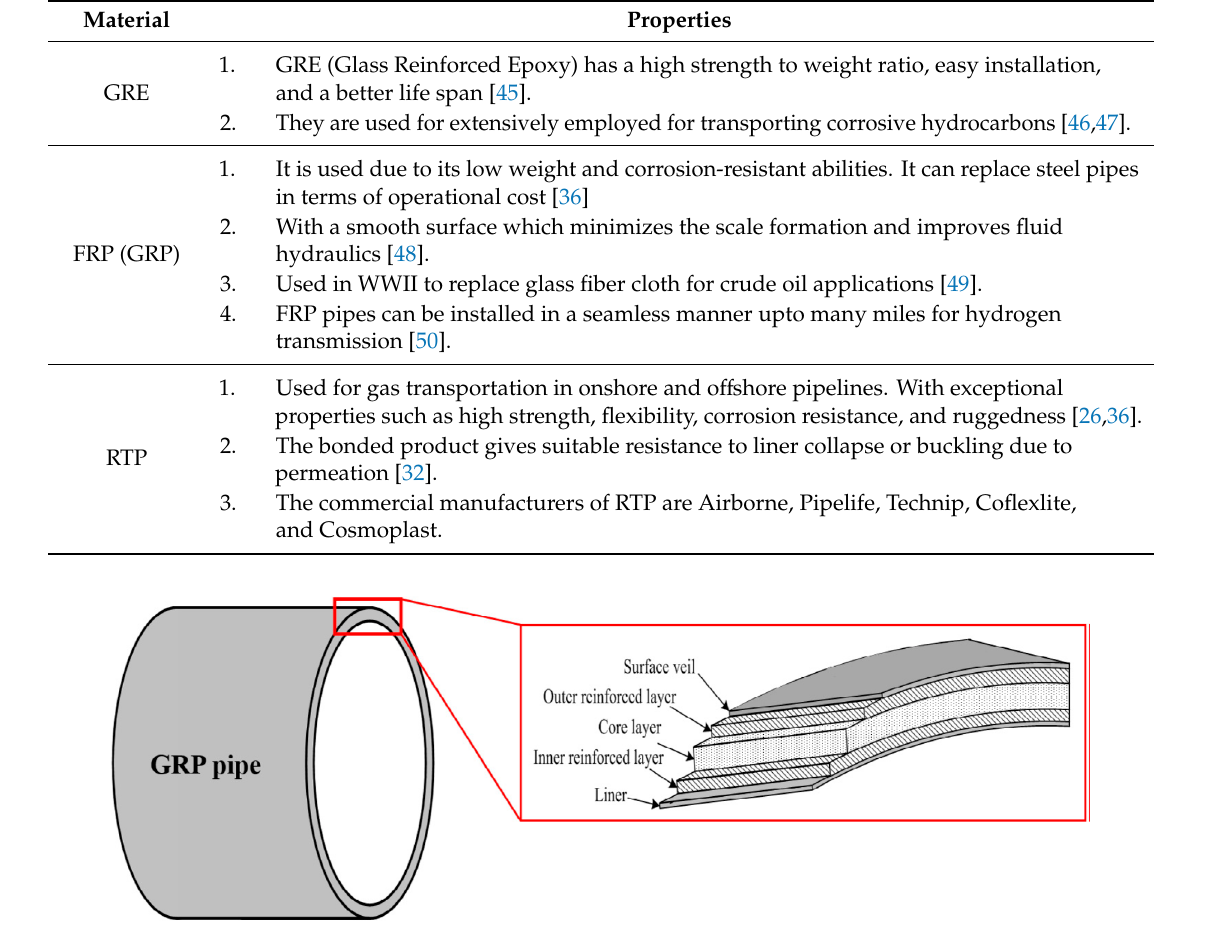
Figure 1. GRP Pipe [30].